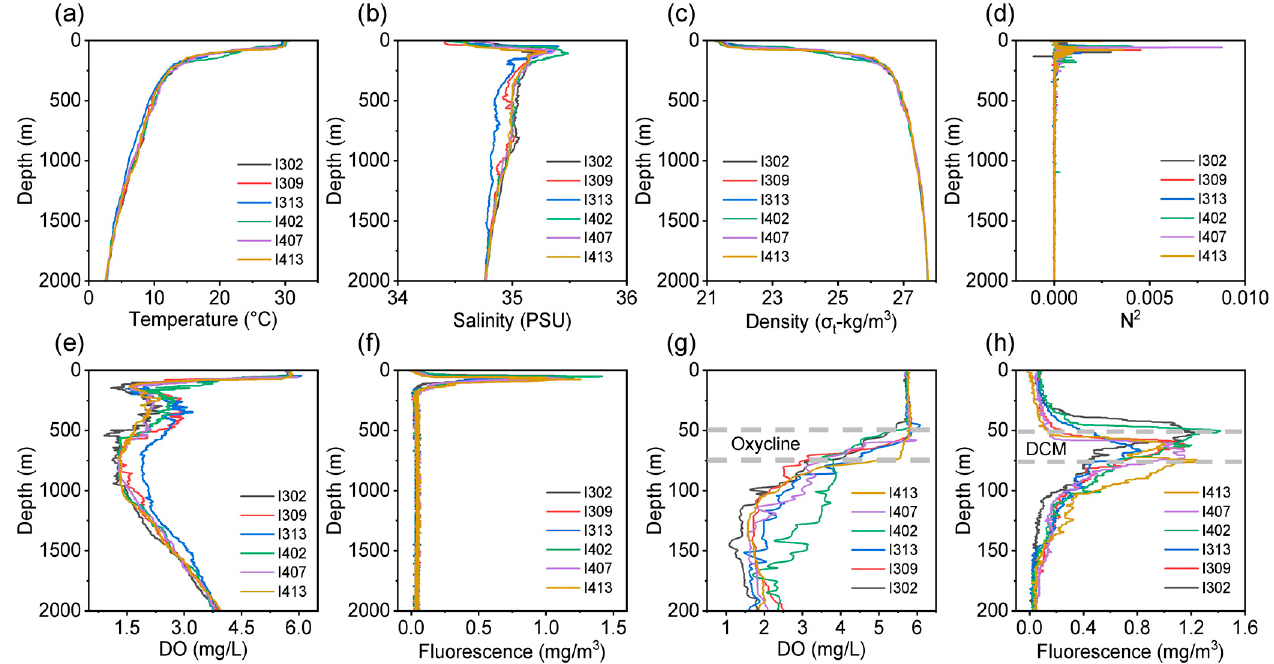
Figure 2. Depth profiles of environmental parameters. ( a ) Temperature ( ◦ C), ( b ) Salinity (PSU), ( c ) Density (sigma-t), ( d ) Brunt–Väisälä frequency (N 2 ). Depth profiles of Chlorophyll and DO in the ( e , f ) entire water column and ( g , h ) upper 200 m water column. The region between dashed gray lines represents the deep chlorophyll maximum (DCM) layer and the oxycline layer.